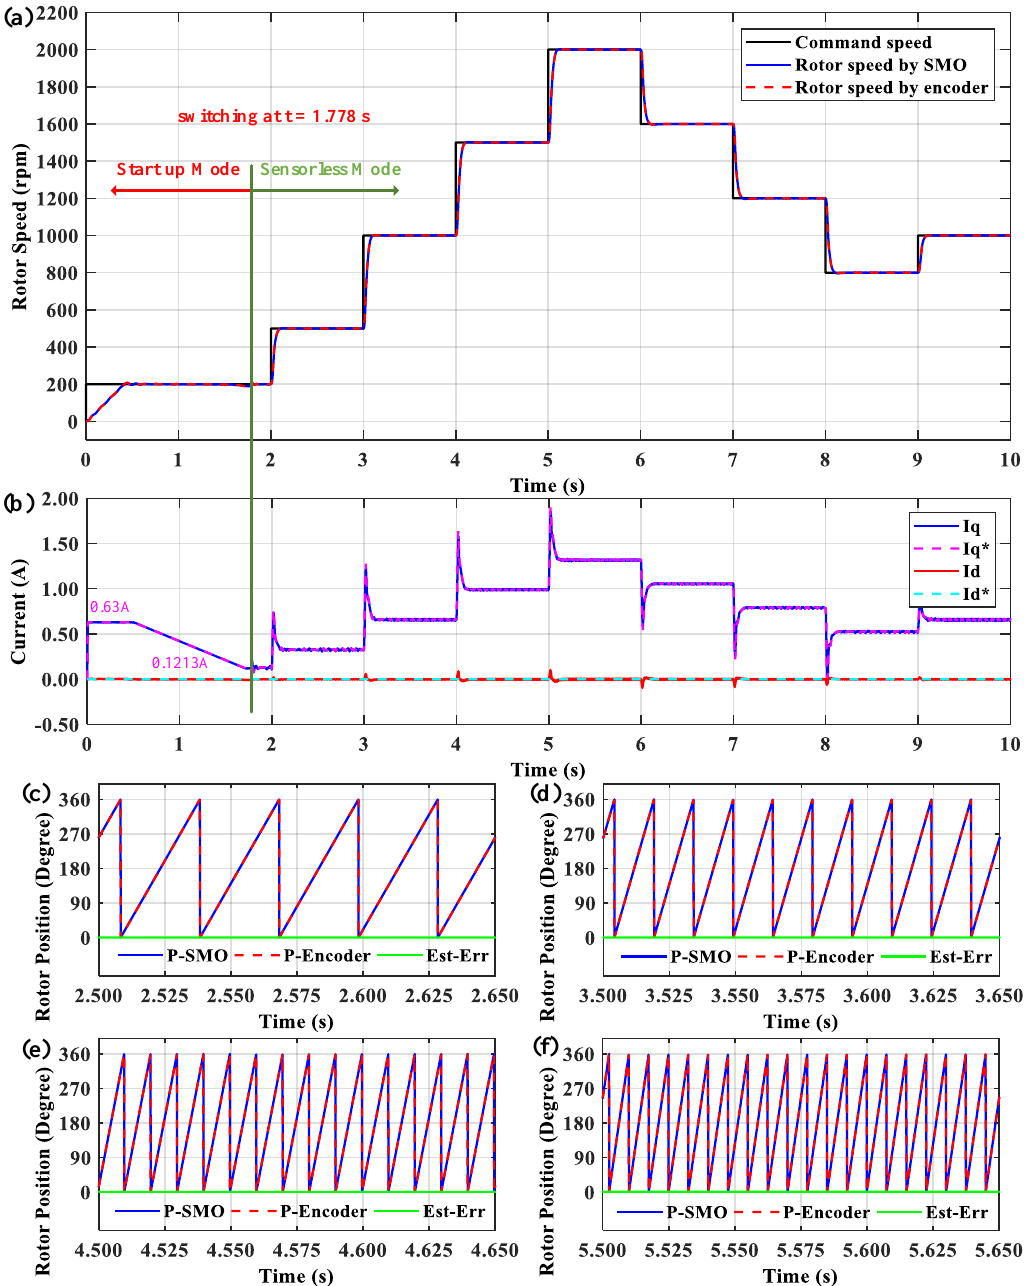
Figure 8. Simulation results in the wide speed range in the positive direction for: ( a ) speed response; ( b ) current response; and rotor position response at ( c ) 500; ( d ) 1000; ( e ) 1500; and ( f ) 2000 rpm.